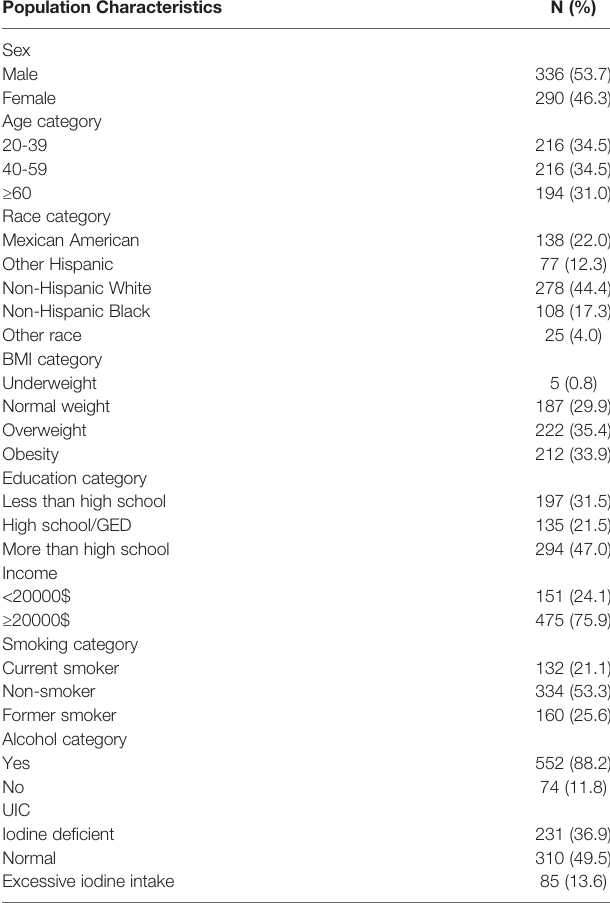
TABLE 1 | Distribution of demographic and laboratory characteristics.